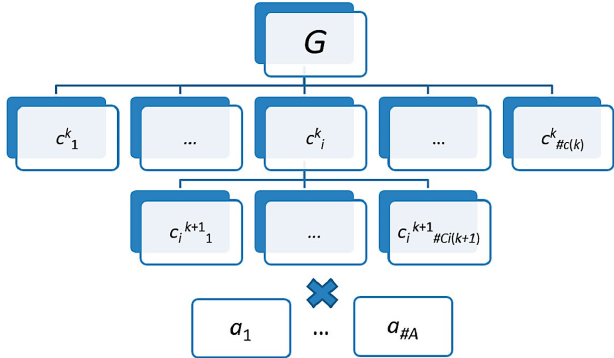
Figure 3. Decision-making problem in a hierarchy